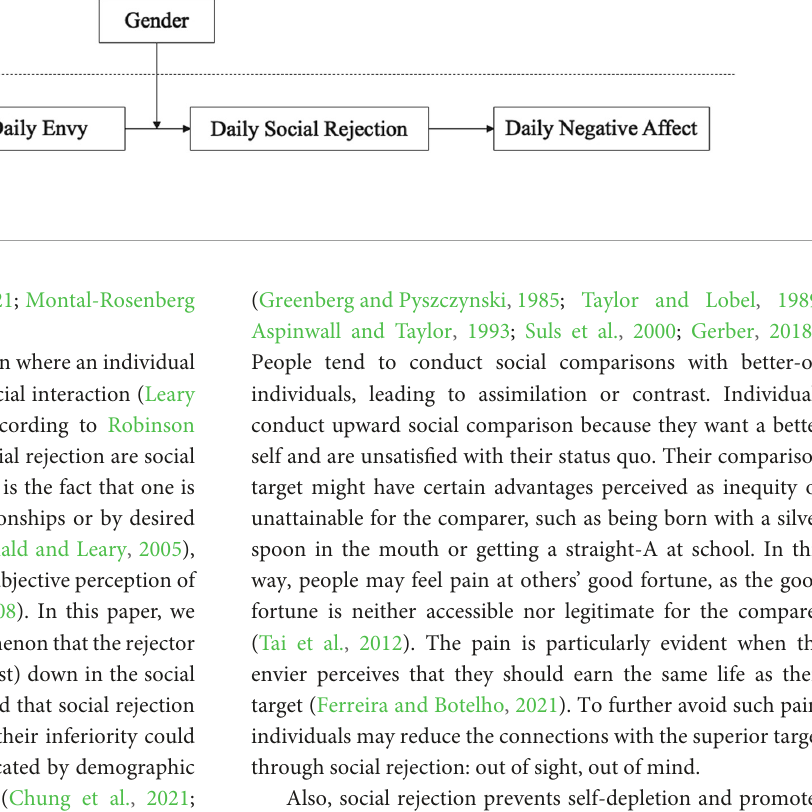
FIGURE1 Theoretical framework for social rejection.